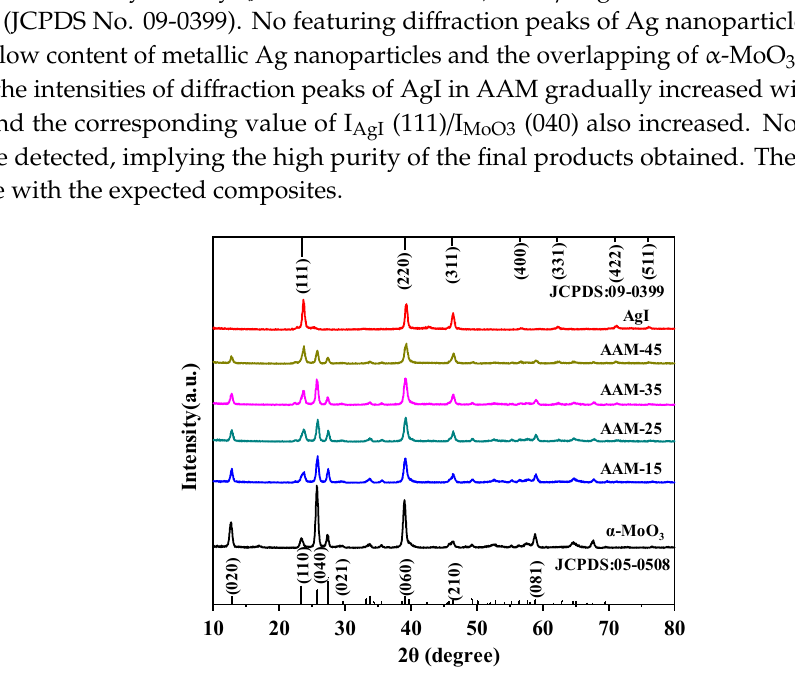
Figure 1. XRD patterns of the as-prepared α -MoO 3 nanobelts, AgI and Ag/AgI/ α -MoO 3 (AAM) heterojunctions.